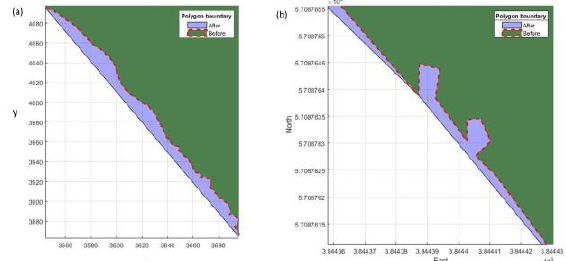
Figure 1 (a) Boundary after outlier removal (b) Final boundary after